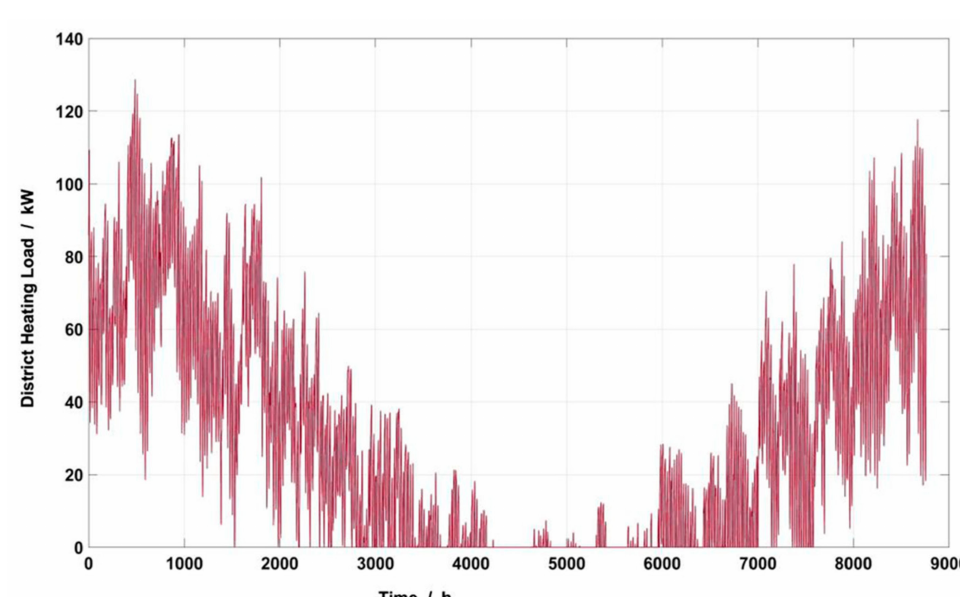
Figure 7. Annual hourly air conditioning heat